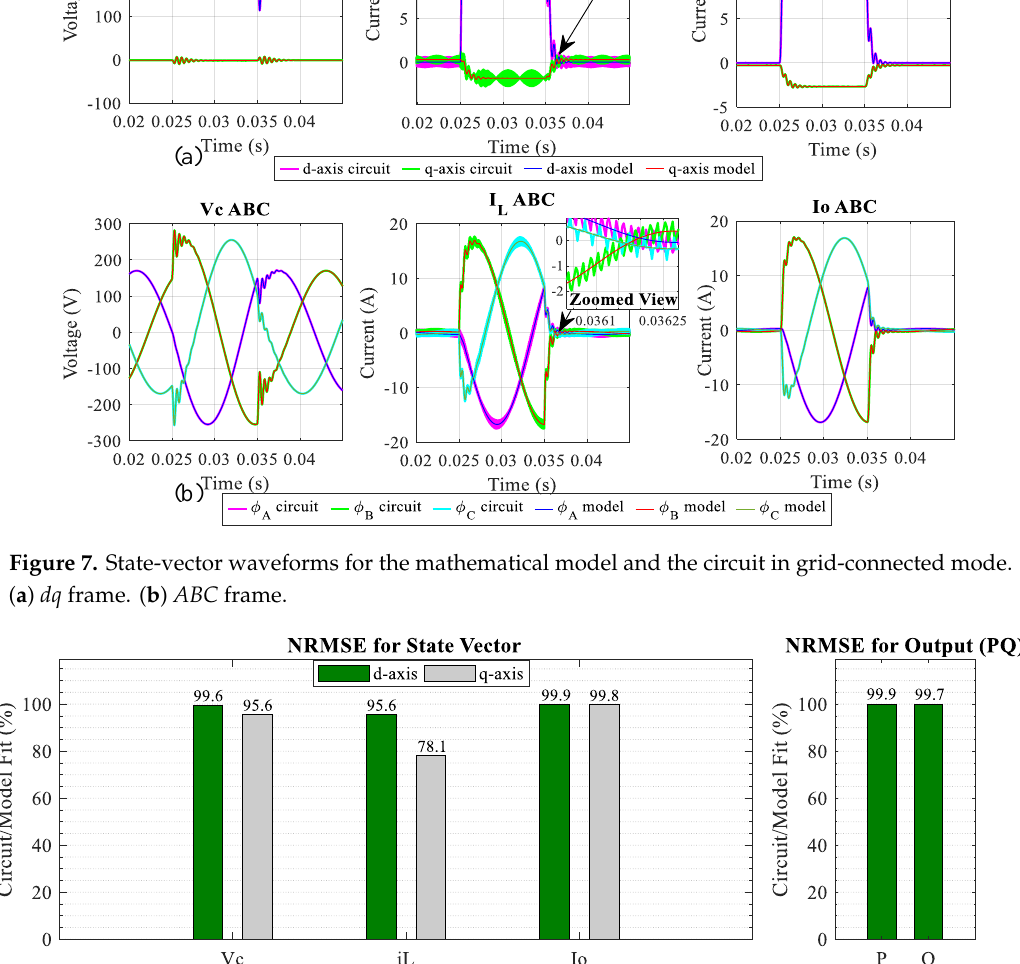
Figure 8. NRMSE for the state vector and shared power.